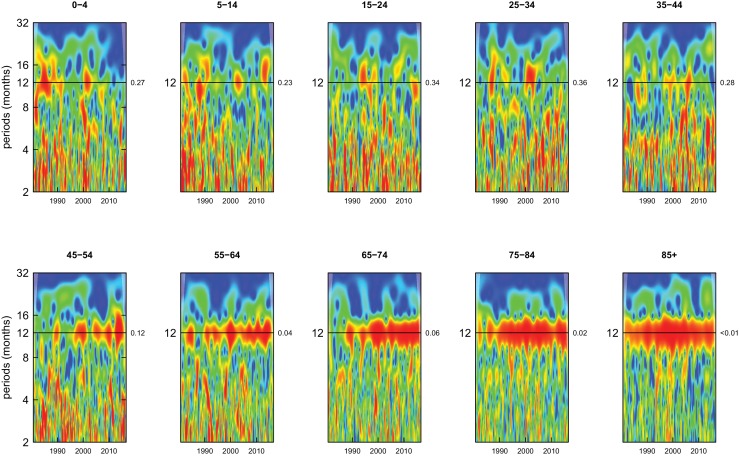
Wavelet power spectra for national time series of endocrine disorder death rates for 1980–2016, by age group for females.Wavelet power values increase from blue to red. The shaded regions at the left and right edge of each box indicate the cone of influence, where spectral analysis is less robust. P-values for the presence of 12 month seasonality are to the right of each figure at the 12 month line.